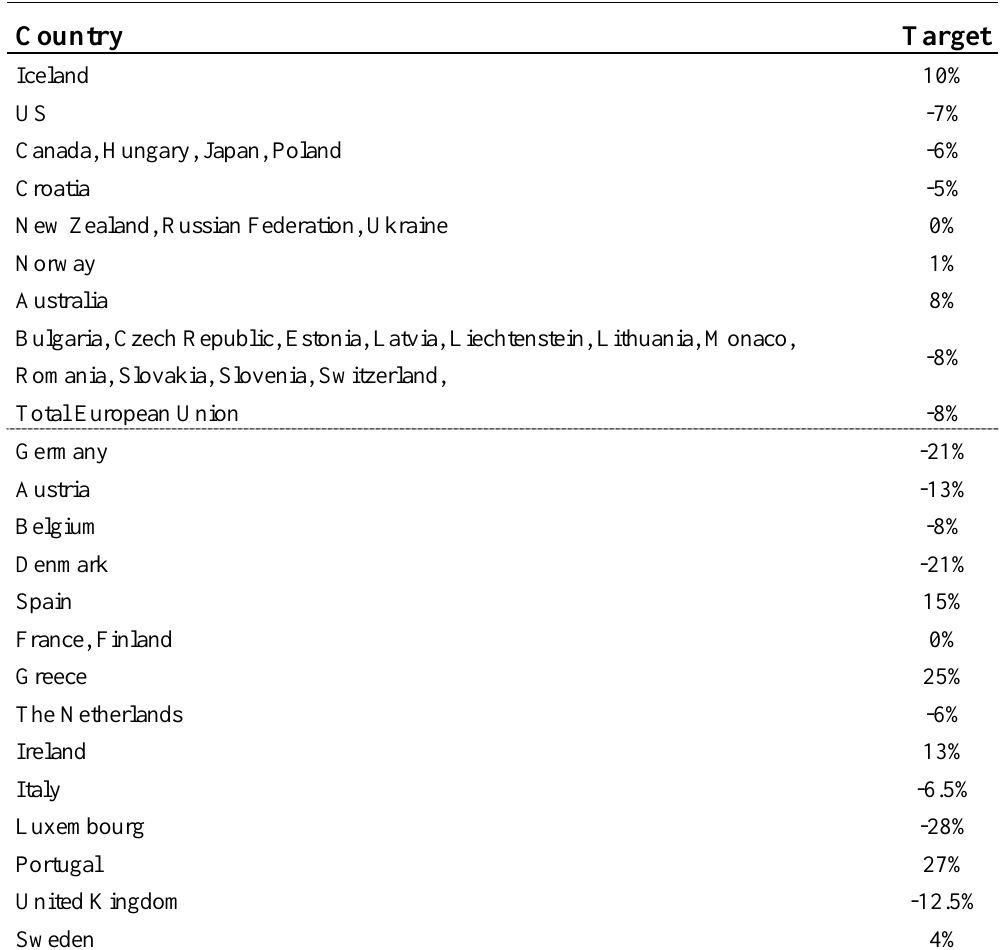
Table 1. Annex B Countries Emission